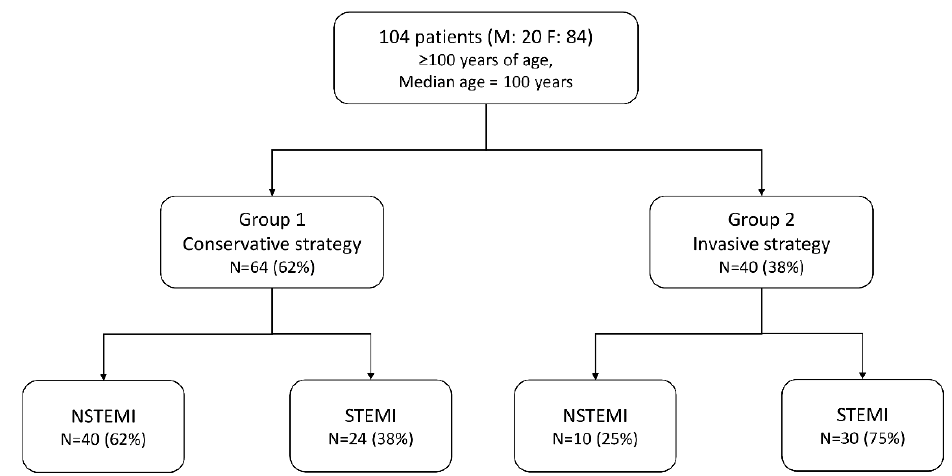
Figure 1. Study design. F = females; M = males; NSTEMI = non-ST-elevation myocardial infarction; STEMI = ST-elevation myocardial infarction.